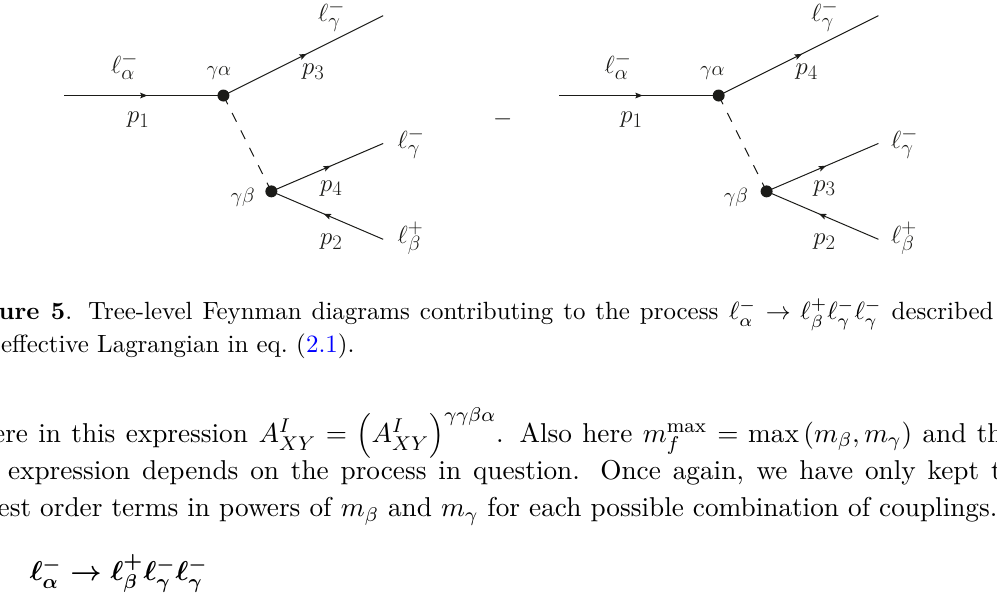
Figure 5 . Tree-level Feynman diagrams contributing to the process ‘ − the effective Lagrangian in eq.